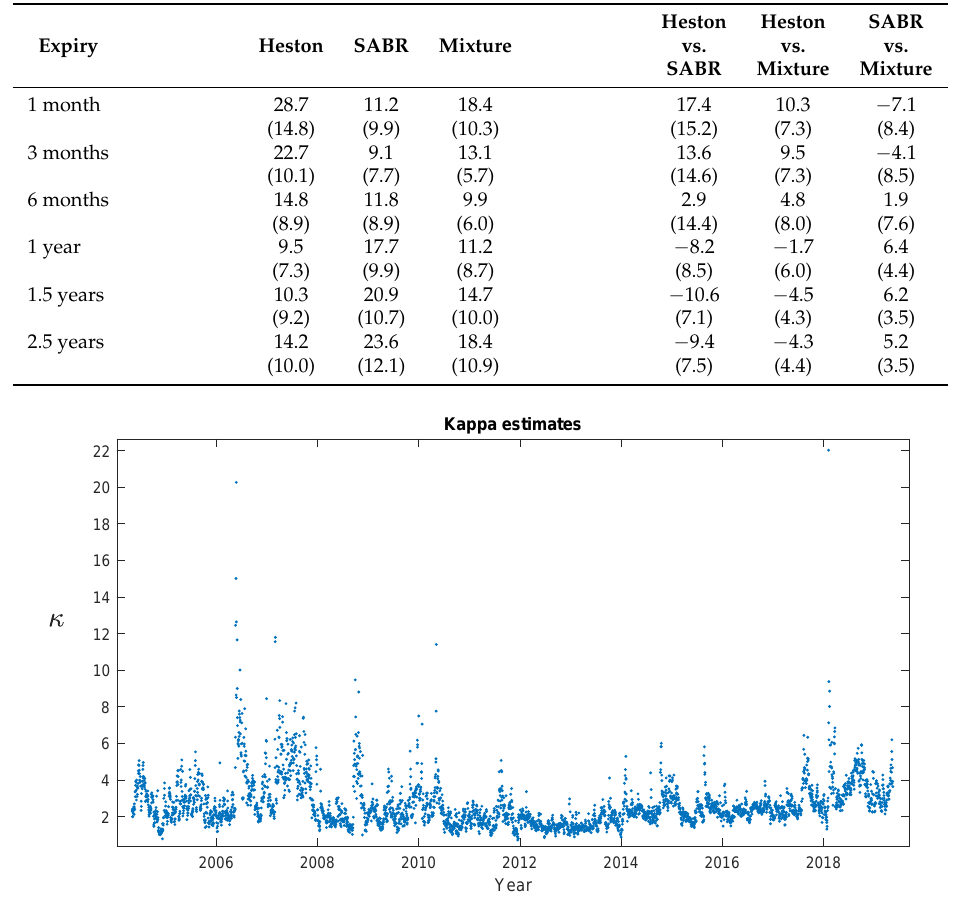
Figure 2. Estimates of the Heston model’s κ under the risk-neutral measure Q obtained from the two-step calibration